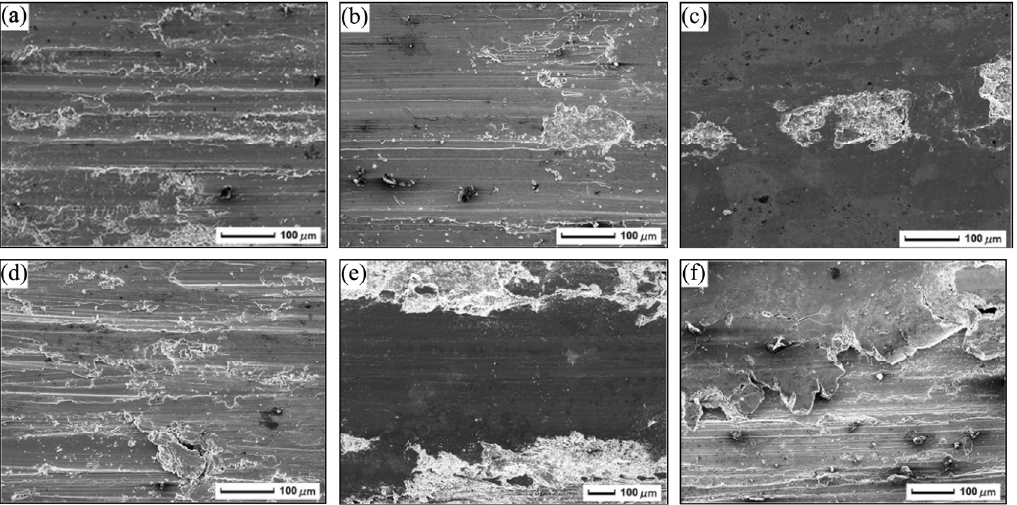
Fig. 12 Morphology of Ti64 worn pin surfaces ensuing counter-body interaction under various sliding conditions: (a) temp = 25 ° C, load = 100 N; (b) temp = 200 ° C, load = 100 N; (c) temp = 400 ° C, load = 100 N; (d) temp = 400 ° C, load = 250 N; (e) temp = 500 ° C, load = 100 N; (f) temp = 500 ° C, load = 250 N. Reproduced with permission from Ref. [2]. Copyright Elsevier,